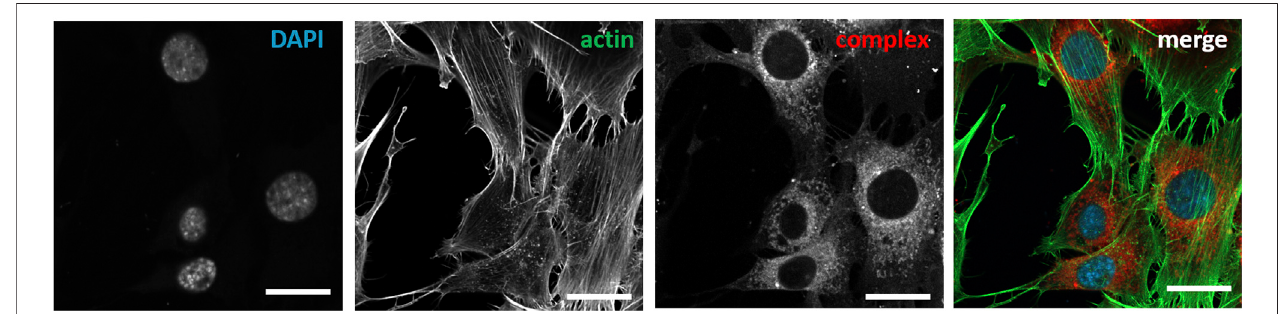
FIGURE6| Post- fi xationimmunochemicalstainingofnucleiandactincytoskeletonofNIH3T3cellstreatedwithcompound 1d .CellsweretreatedwithDAPI( λ exc (cid:1) 405nm, λ em (cid:1) 410 – 470 nm), Actin ( λ exc (cid:1) 488 nm, λ em 490 – 535 nm); compound 1d ( λ exc (cid:1) 640 nm, λ em (cid:1) 656 – 700 nm).